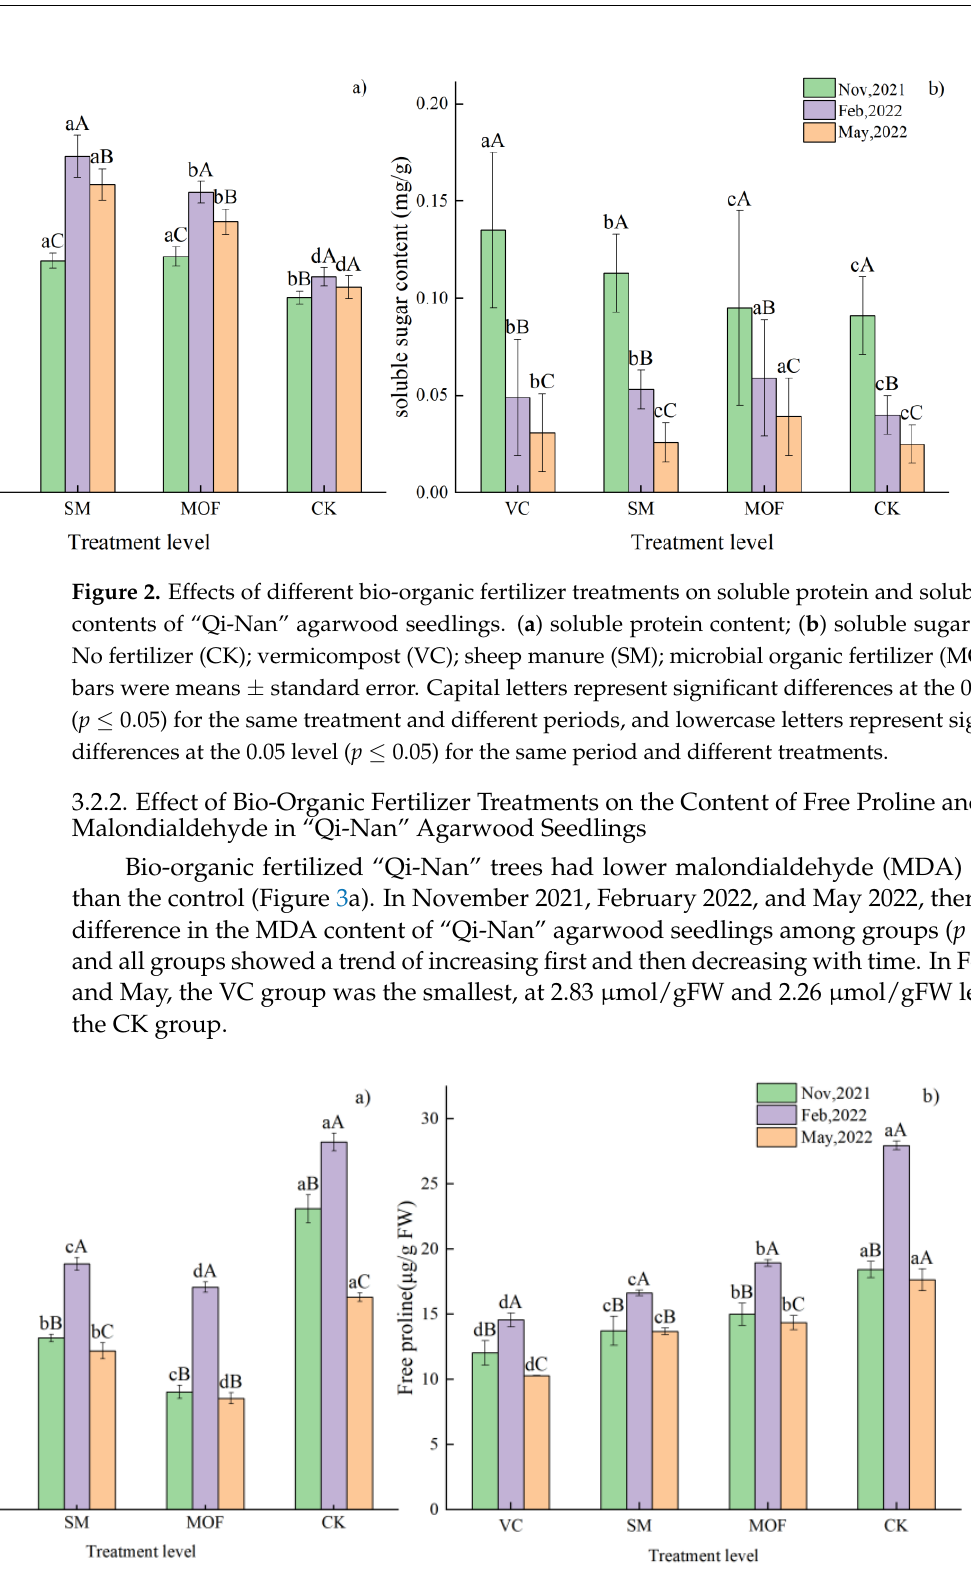
Figure 2. Effects of different bio-organic fertilizer treatments on soluble protein and soluble sugar contents of “Qi - Nan” agarwood seedlings. ( a ) soluble protein content; ( b ) soluble sugar content. No fertilizer (CK); vermicompost (VC); sheep manure (SM); microbial organic fertilizer (MOF). The bars were means ± standard error. Capital letters represent significant differences at the 0.05 level (p ≤ 0.05) for the same treatment and different periods, and lowercase letters represent signif- icant differences at the 0.05 level (p ≤ 0.05) for the same period and different treatments.